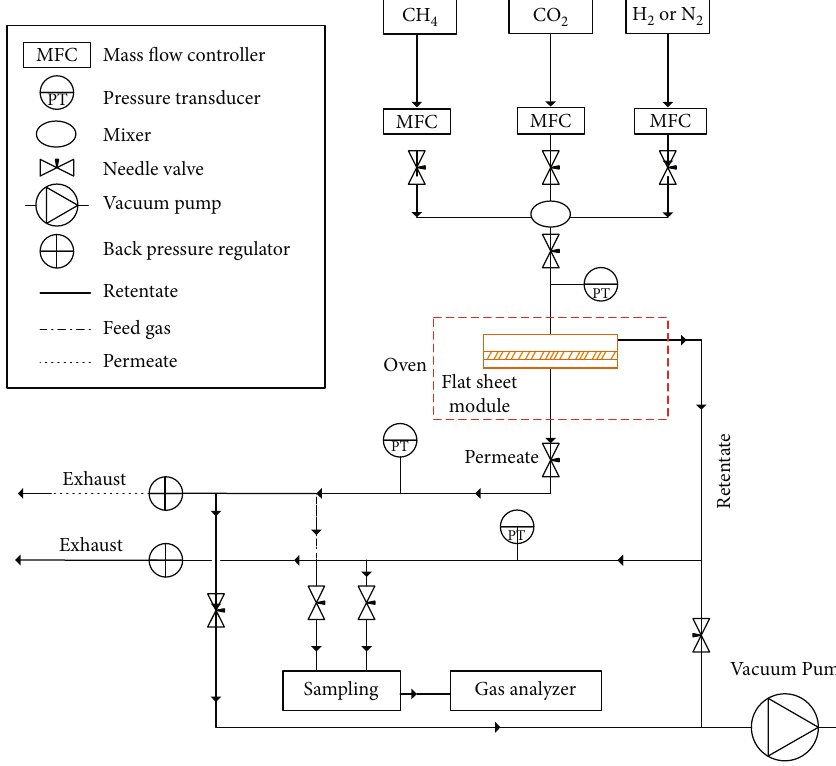
Figure 1: Schematic of permeation test rig used in the present